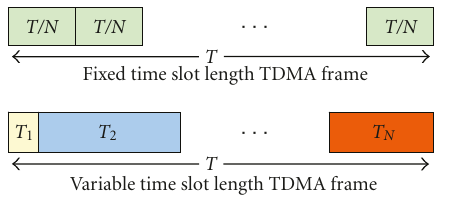
Figure 2: Fixed and variable time-slots length TDMA frames.